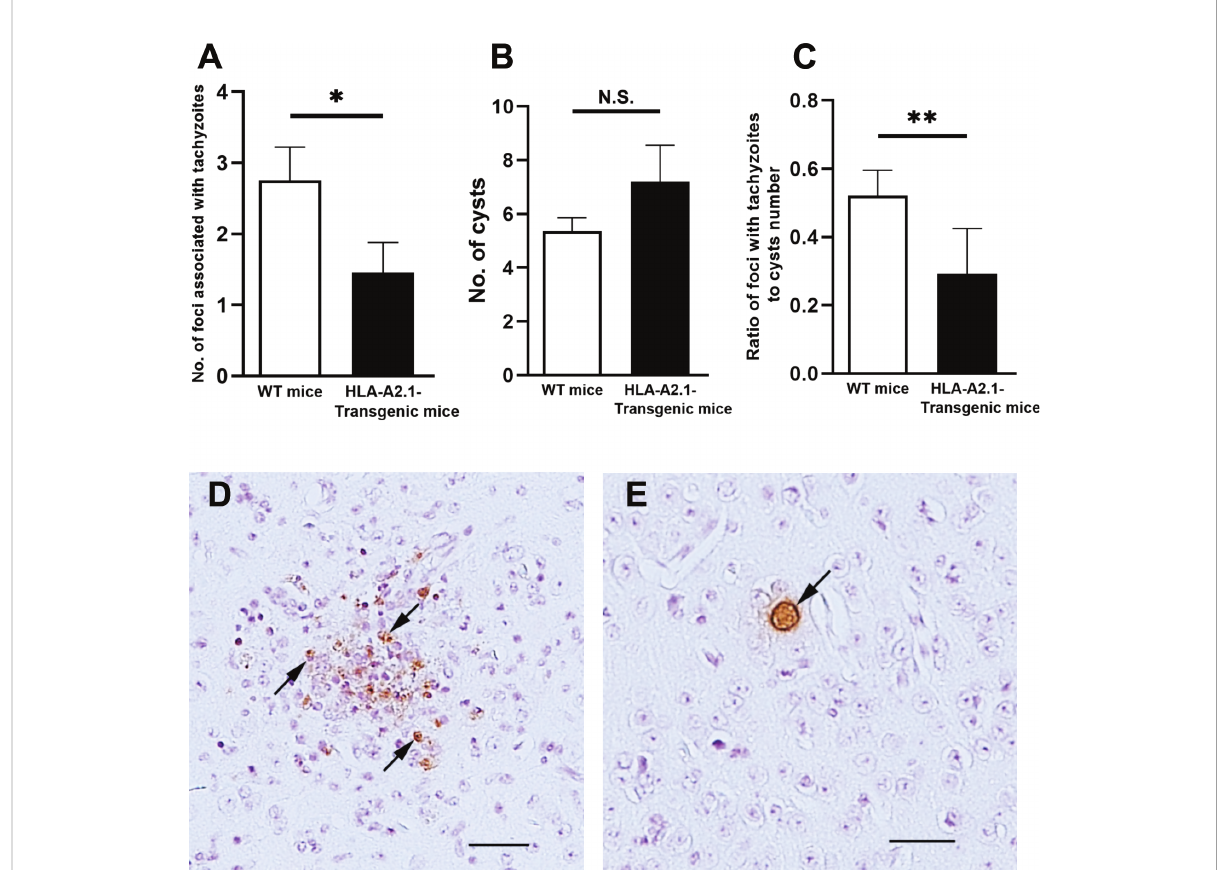
FIGURE 2 The HLA-A2.1-transgenic mice have fewer areas of foci associated with tachyzoites than do WT control mice in their brains during reactivation of cerebral infection with T. gondii . The HLA-A2.1-transgenic and WT control mice were infected with 10 cysts of the ME49 strain and treated with sulfadiazine beginning at 7 days after infection for 10 days to control tachyzoite proliferation during the acute stage of infection and establish chronic infection in their brains. Four to fi ve weeks after discontinuation of sulfadiazine, which induces reactivation of the cerebral infection, immunohistochemical analyses staining for the parasite were performed on the sagittal sections (4 m m thickness) of their brains, and numbers of the foci associated with tachyzoites and numbers of the cysts were microscopically counted in the entire fi led of each sagittal section. A total of 4 or 5 sections (at least 40 m m distance between sections) were analyzed for each mouse, and the mean value from the counts from those sections were calculated for each of the number of (A) tachyzoite-associated foci and (B) the cysts, and (C) ratios of the tachyzoite-associated foci number to the cyst number for each mouse. (D) A representative image of the foci associated with tachyzoites (some representative tachyzoites are allowed) and an accumulation of in fl ammatory cells. (E) A representative image of the cysts (the cyst wall is allowed). The bars in the panels D and E indicate the distance of 50 m m. * P <0.05, ** P <0.01. N.S. Not signi fi cant. The data were combined from two independent experiments (n= 12 for the HLA-transgenic mice, and n=15 for the WT control